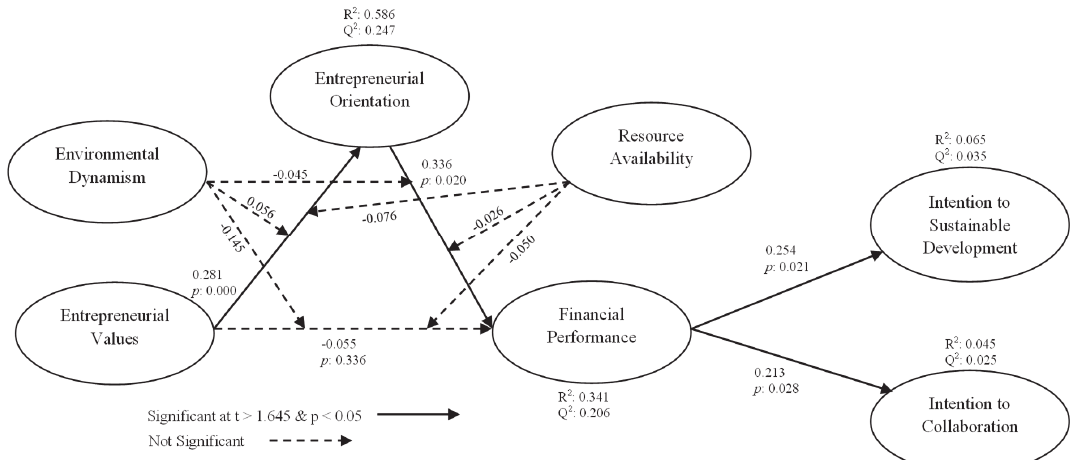
Fig. 2. Empirical Model with Path